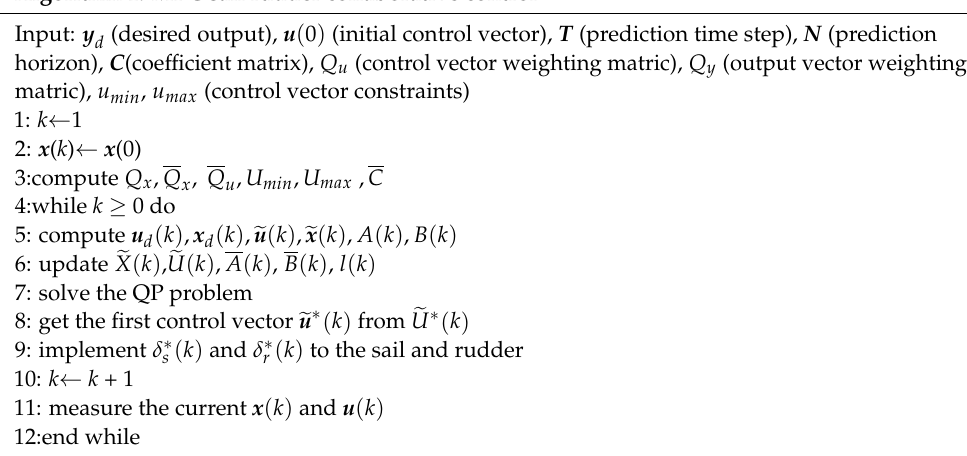
Algorithm 1: MPC sail rudder collaborative